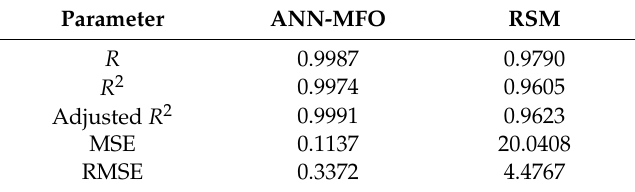
Table 7. Statistical indices for ANN and response surface methodology (RSM)